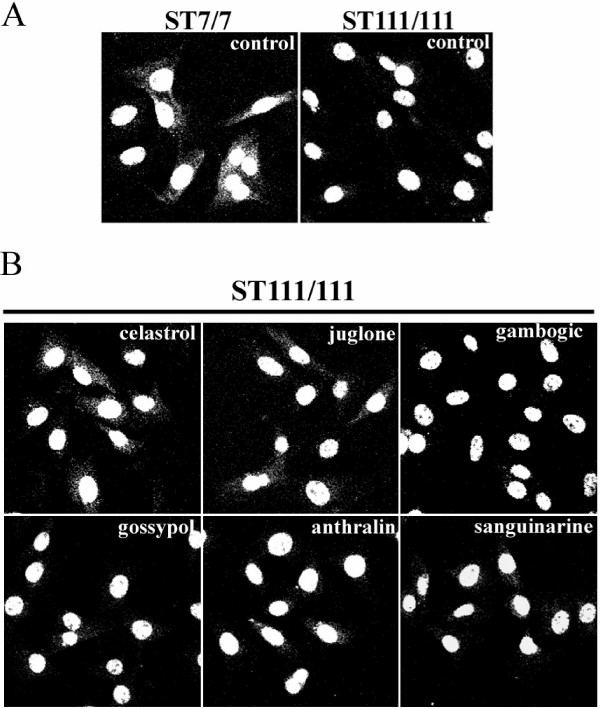
Localization of huntingtin in wild type and mutant striatal cell from knock-in mice. Cells were cultured for 48 hours and immunostaining was done with a specific antibody against huntingtin, AP229, followed by Cy3 labeled secondary antibody. The signal was visualized by confocal microscopy (magnification: ×20). A. The localization of full-length huntingtin of striatal cell lines: ST7/7 and ST111/111 with 2.5% DMSO. B. The localization of huntingtin of mutant striatal cell, ST111/111, after treated with drugs at 10 μM.